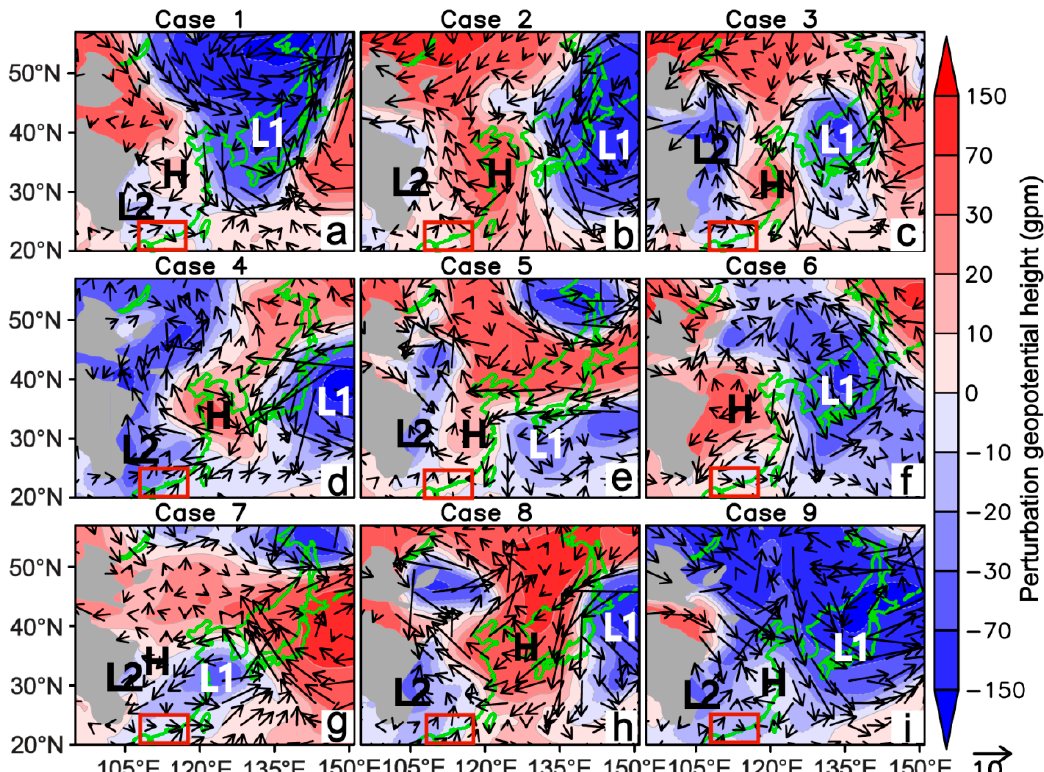
Figure 8. Distributions of SSTA-GH (color-shaded; units: gpm) and synoptic-scale transient anomaly of wind vector (units: m s -1 ) at 850 hPa near the time when MCSs turned to move southeastward ( a – i : cases 1–9; a : 1400 BT 11 April 2012; b : 0800 BT 6 April 2014; c : 2000 BT 8 May 2014; d : 1400 BT 22 May 2014; e : 1400 BT 30 April 2015; f : 1400 BT 4 May 2015; g : 2000 BT 3 April 2016; h : 0800 BT 15 April 2016; i : 0800 BT 19 April 2017). “H”, “L1” and “L2” indicate the high SSTA-GH near eastern China and the low SSTA-GHs over northwestern Pacific Ocean and Southwest China, respectively. The gray-shaded area is the Tibetan Plateau. The rectangles indicate the position of South China, where sudden turning motion of the MCSs occurred.